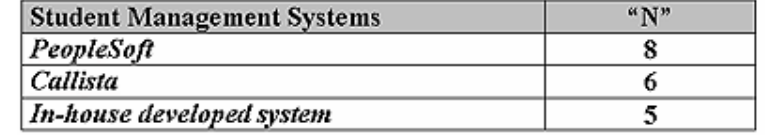
Table 4. Numbers of SMS systems used in Australia's 34 universities (NCODE-FLA,